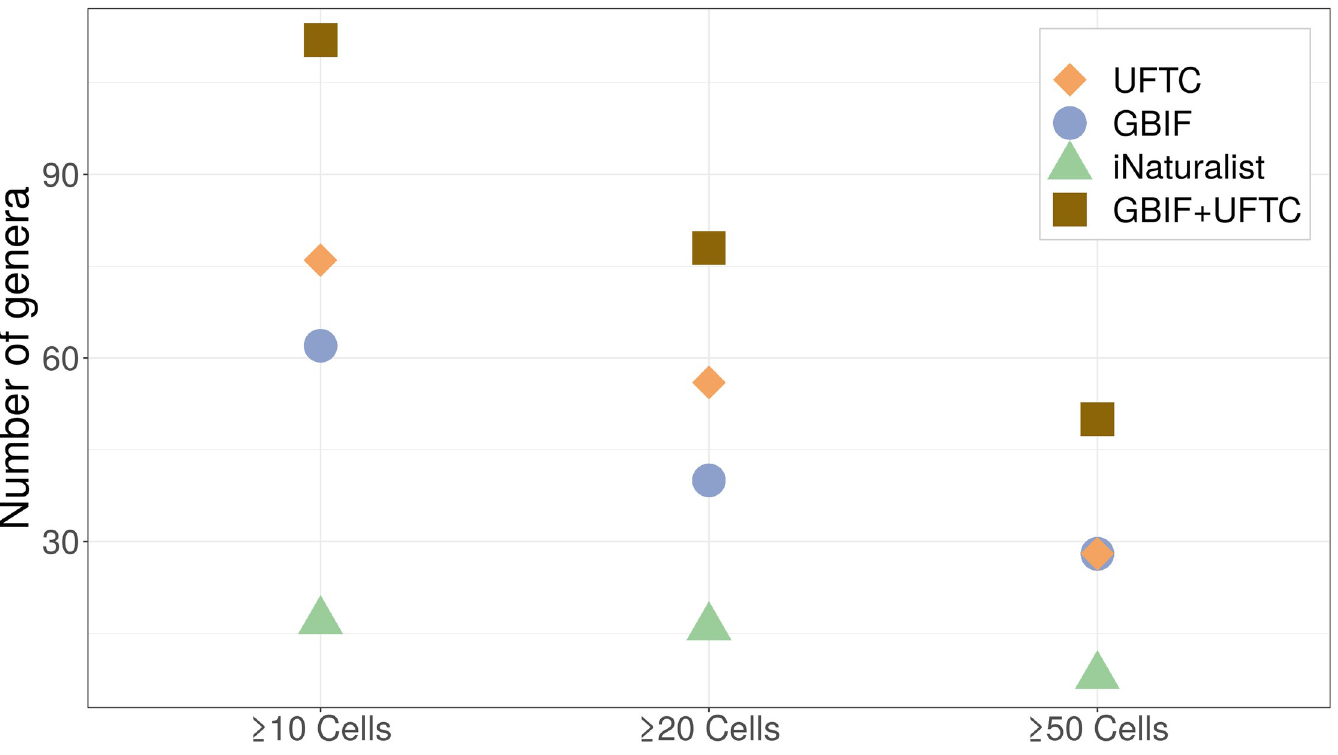
Fig 5. Number of termite genera covering � 10, � 20, and � 50 distinct 0.1-degree cells for individual data sources and one combination. https://doi.org/10.1371/journal.pone.0226534.g005 data) only indicates that the necessary number of experts have not yet attempted to identify the species or genus level of an observation, and that it does not say anything about the accu- racy of the record itself.